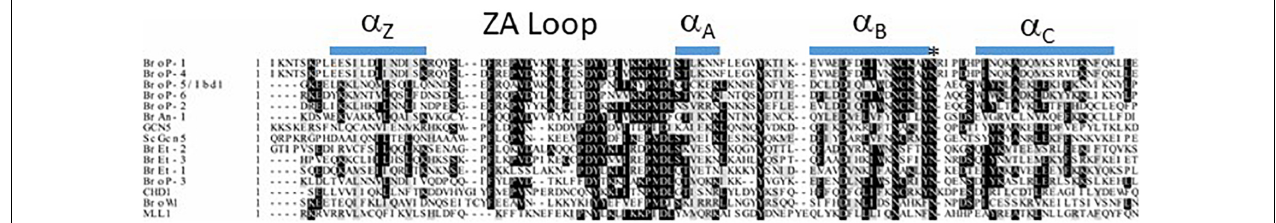
FIGURE 3 | Multiple sequence alignment of 14 Tt bromodomains (BRD). BRD sequence was extracted from the respective full length sequence using SMART. Clustal Omega was used to perform multiple sequence alignment (EMBL-EBI) and shaded using BoxShade (ExPASy) with absolutely conserved residues indicated by a black shade and conserved residues by a gray shade. The asterisk represents the highly conserved Asparagine (N) that makes contact with acetyl-lysine. Predicted secondary structure (JPRED) is shown along the top of the